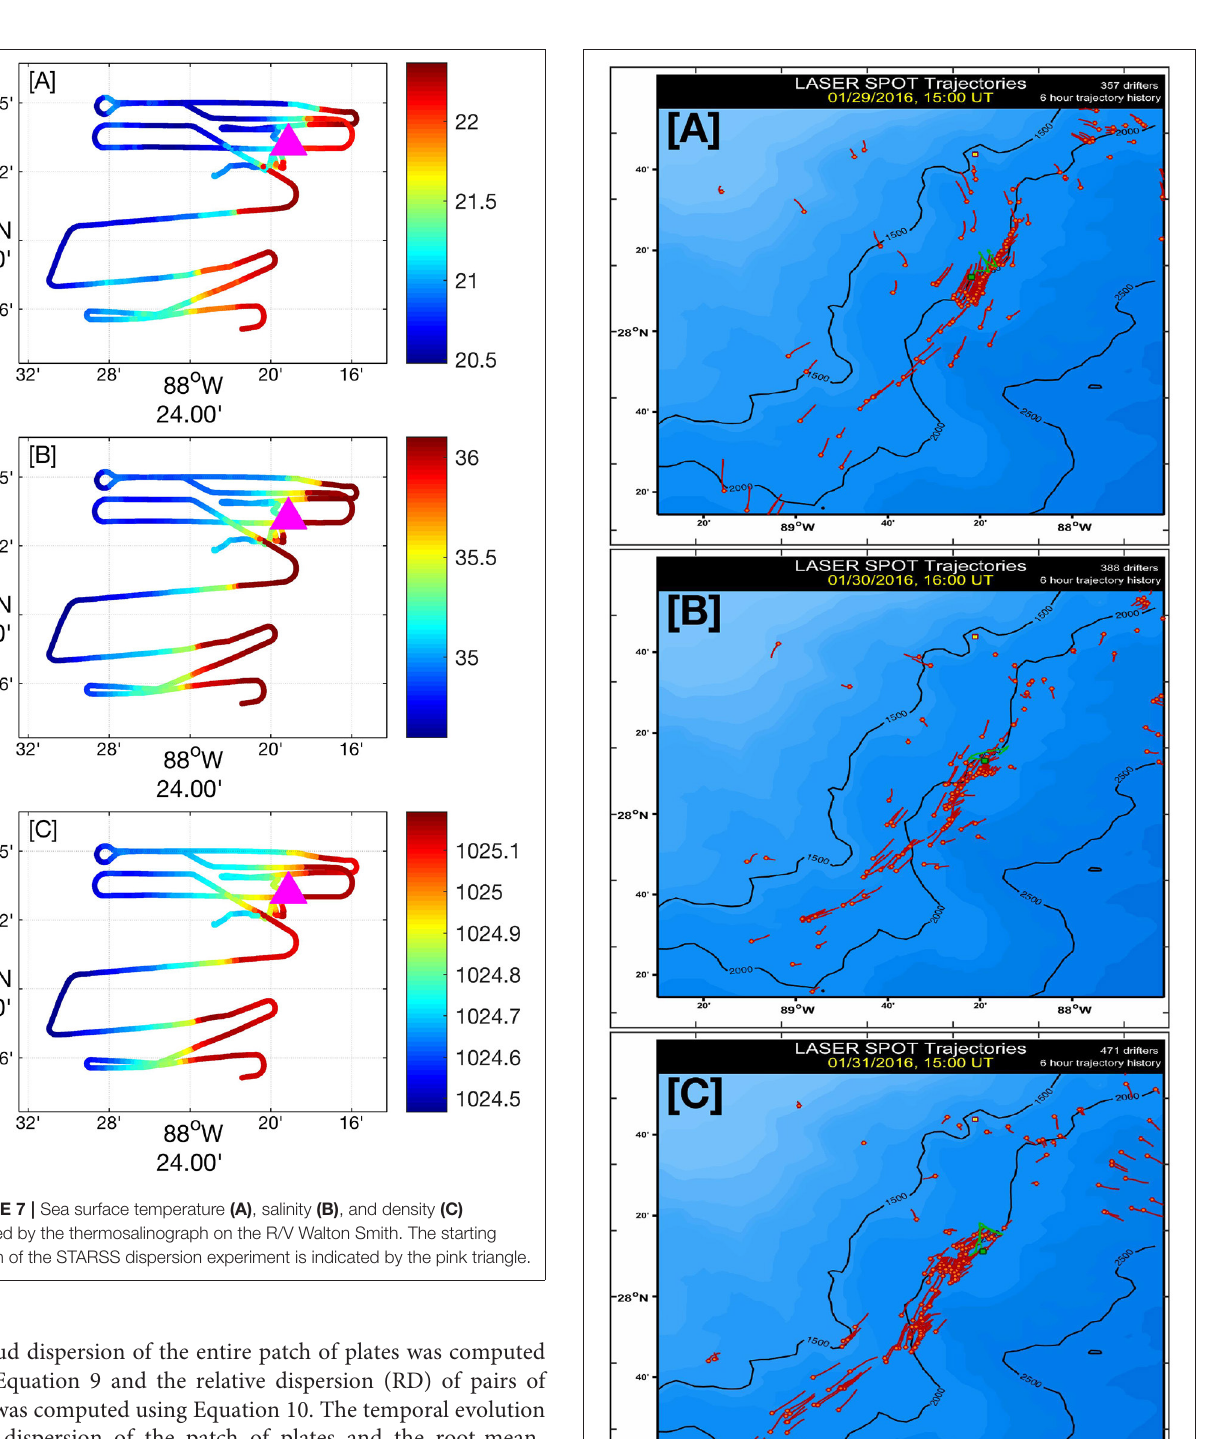
Cloud dispersion of the entire patch of plates was computed using Equation 9 and the relative dispersion (RD) of pairs of plates was computed using Equation 10. The temporal evolution of the dispersion of the patch of plates and the root-mean- square (RMS) average of the RD is shown in Figure 12A . The contraction observed after deployment ( Figure 11B ) is evident in a gradual decrease in cloud dispersion and RMS RD from 0 to 5 min ( Figure 12A ). A power law fit to the cloud dispersion over the interval 5–16 min suggests quasi-diffusive dispersion with σ 2 ∼ t 0.63 (determined by a power law fit to the subset of data using Matlab’s curve fitting tool; R 2 = 0.91). The RMS RD during